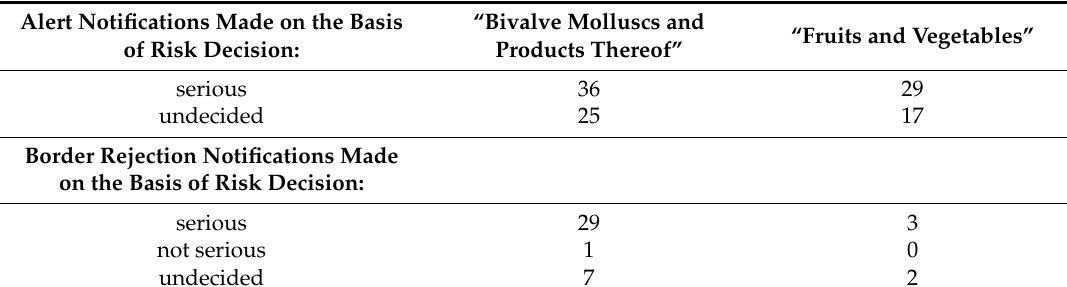
Table 3. Alert and border rejection notifications (according to risk decision) for all types of food product categories, concerning “norovirus” until 31 August 2017, in the EU RASFF.